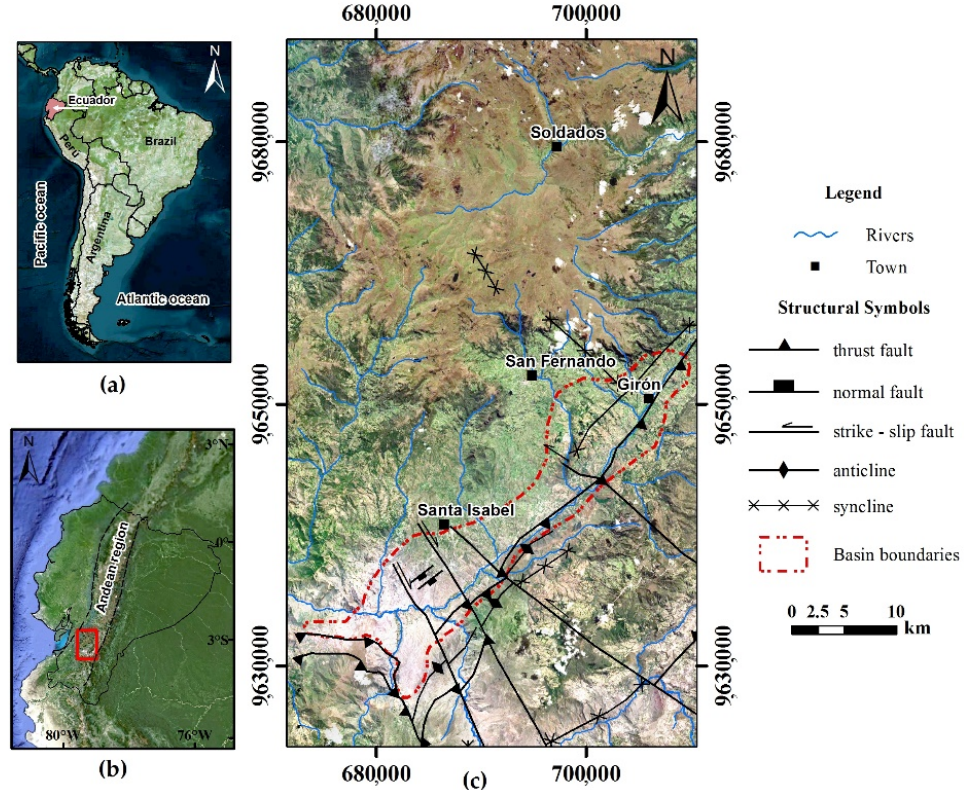
Figure 1. The studied area is located in Ecuador ( a ), in the area of Azuay ( b ) in the Santa Isabel– Giron basin ( c ). basin ( c